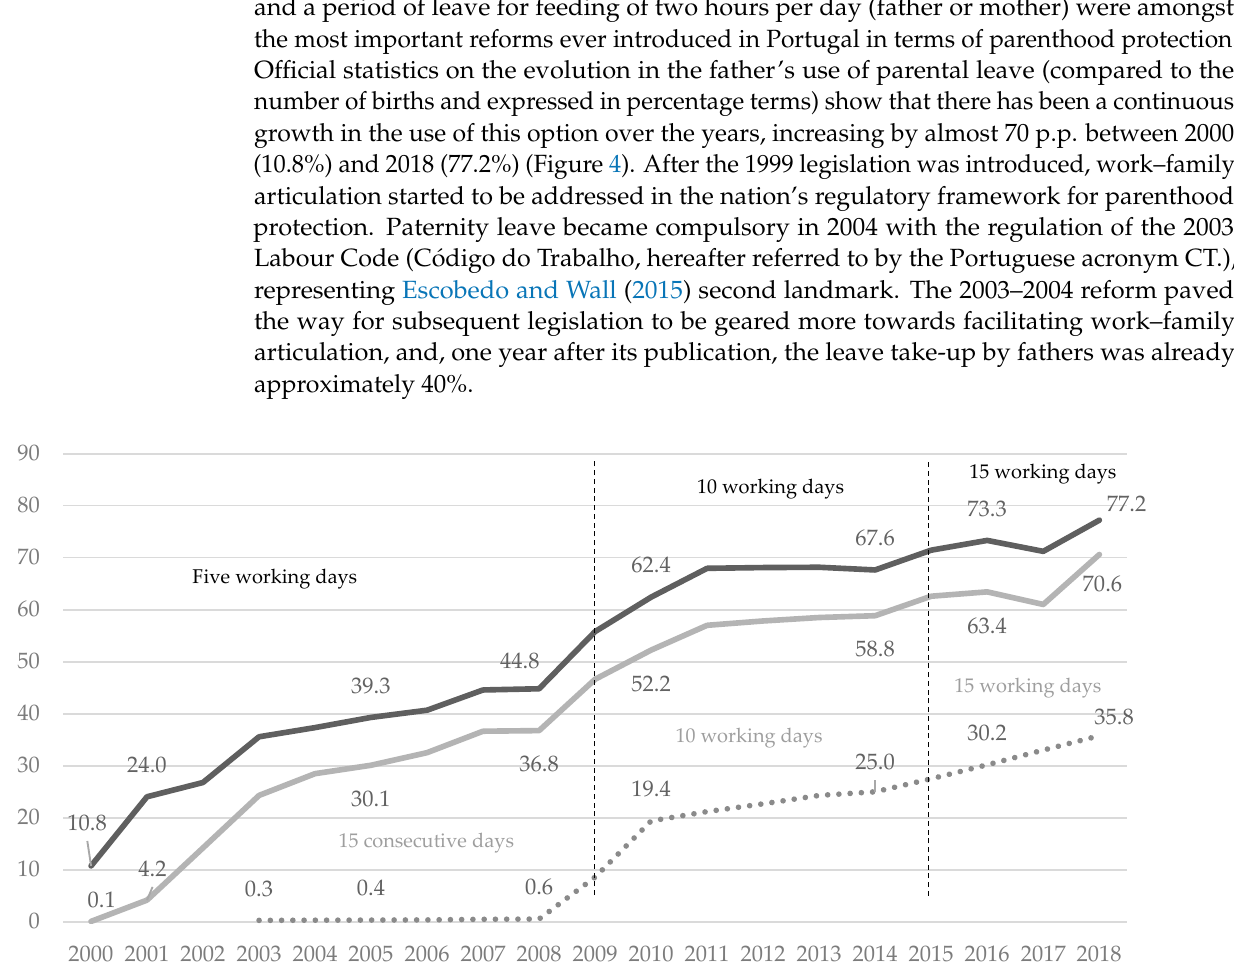
Figure 4. Evolution in father’s use of parental leave (percentage of number of births). Sources: CITE (2019); own calculations from Correia and Cunha (2020), Leit ã o et al. (2019), Wall et al. (2011, 2012, 2013, 2016). Notes: Data for shared leave are aggregated with the father’s compulsory exclusive parental leave of five working days for the years 2000, 2001 and 2002 (only disaggregated from 2003 onwards [inclusive]) and exclude cases of shared leaves due to the mother’s death or physical or mental disability. From 2010 onwards, data exclude shared leaves of less than 30 days, or 15 consecutive days, i.e., those that did not benefit from the